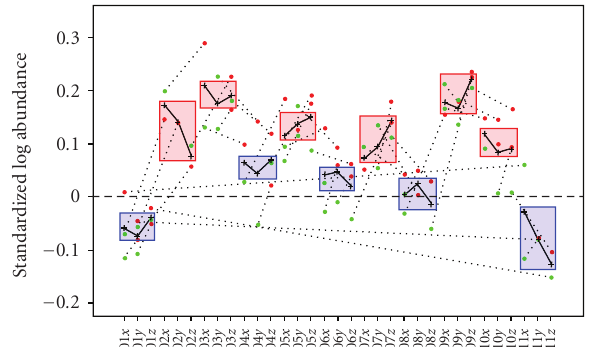
Figure 5: Expression data for alpha-2-HS-glycoprotein, with an average increase of 1.49-fold between the female and male groups, and FDR-adjusted gender-e ff ect P -value = .055. The samples are in SubjectNumberTime format, where SubjectNumber ranges from 01 to 11, and the Time values { x , y , and z } correspond to { T 1 , T 2 , and T 3 } . The annotations indicate the gels (numbers) and the dyes (red for Cy5, green for Cy3) corresponding to the samples. Dotted lines connect samples multiplexed on the same gel. Crosses indicate sample averages over the technical replicates. The solid line connects all sample averages. Boxes around the three Time values for each SubjectNumber highlight male and female genders (blue and red respectively) added for illustrative purposes